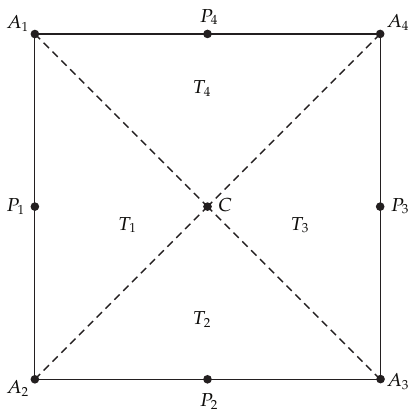
Figure 4: Rectangular partition and its